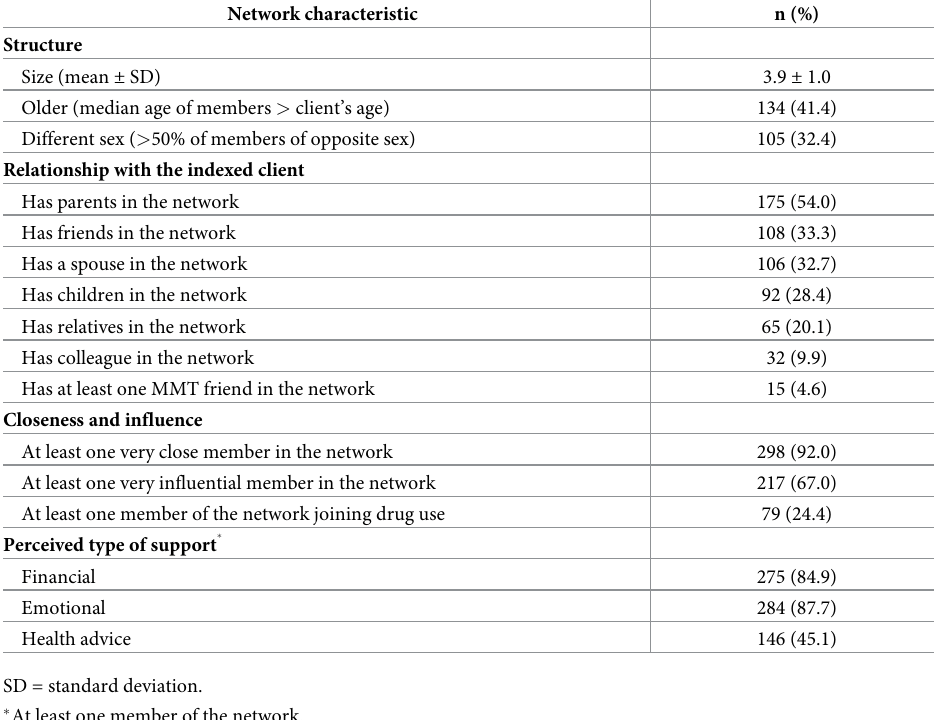
Table 2. Characteristics of social network of MMT clients (N =